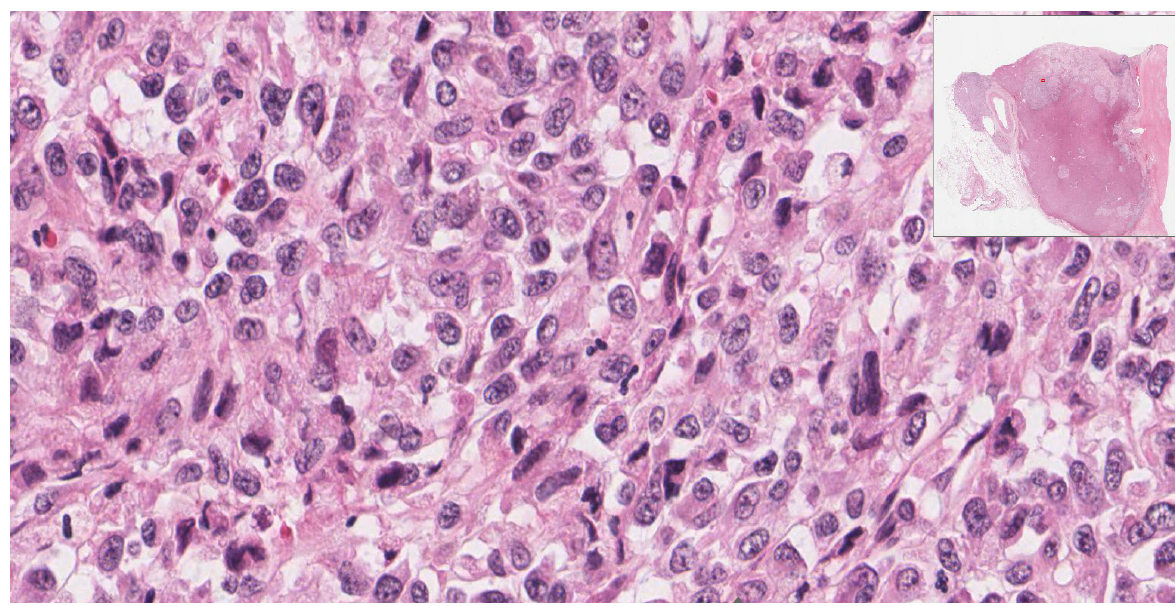
Figure 4. (40x): Sarcoma component: pleomorphic spindle cells with nuclear hyperchromasia. The carcinoma component shows positive staining for calretinin (cytoplasmic and nuclear staining), inhibin (cytoplasmic staining), and synaptophysin (diffuse cytoplasmic of the tumor was stained for vimentin (cytoplasmic staining) and desmin (cytoplasmic